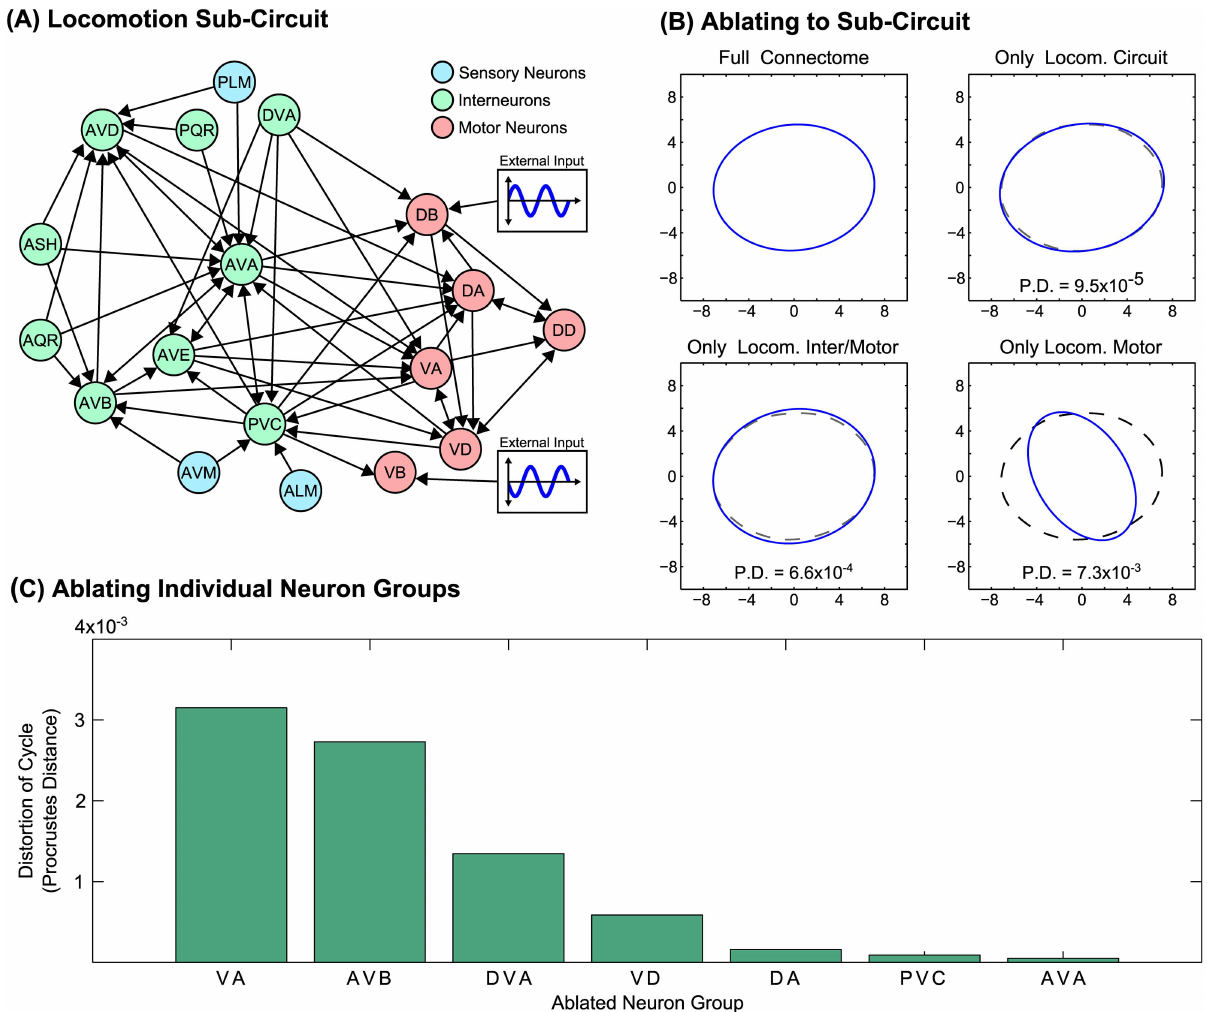
Fig 7. (A) The subnetworkof neuronsassociatedwith locomotion, as in [34]. Arrows indicate the presenceof multiplesynaptic connections [30]. (B) . The cycle resultingfrom sinusoidaldriving( k = 0.886) when the network is reducedto the given subcircuit(i.e. when all other neuronsare ablated). The locomotory subcircuitsustains a nearly identicalresponse to the full network, as do the locomotory inter/ motorneuronsalone, but eliminating the interneurons results in a substantialdistortion of the cycle. This distortion from the full-network response is quantifiedvia the Procrustes distance. (C) Cycle distortion when specific neuronsare ablated. The interneuron ablations leading to the highestlevel of distortion are known to cause distorted forward locomotion when ablatedexperimentally (e.g. when ablatingAVB [28] or DVA